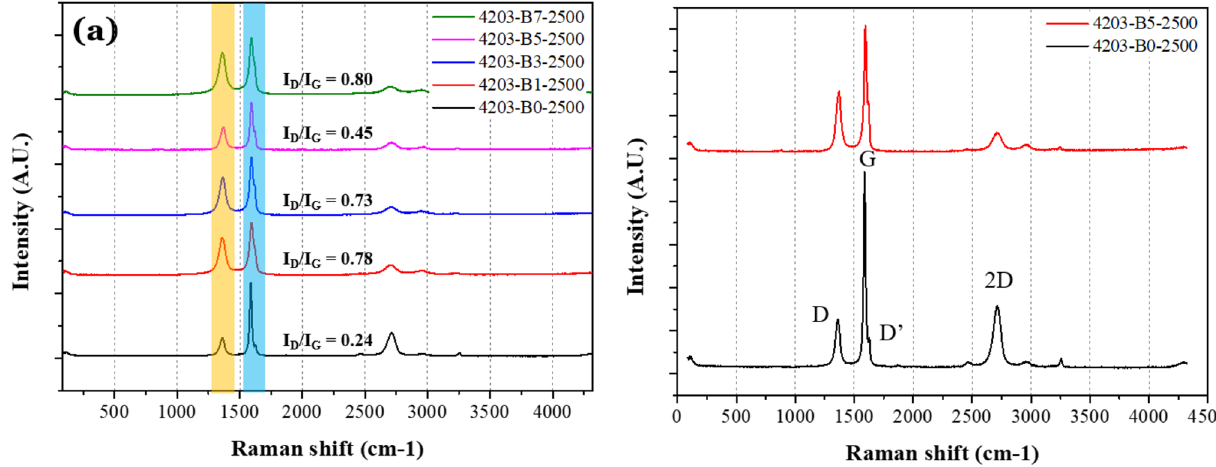
Fig. 5 Raman spectra of